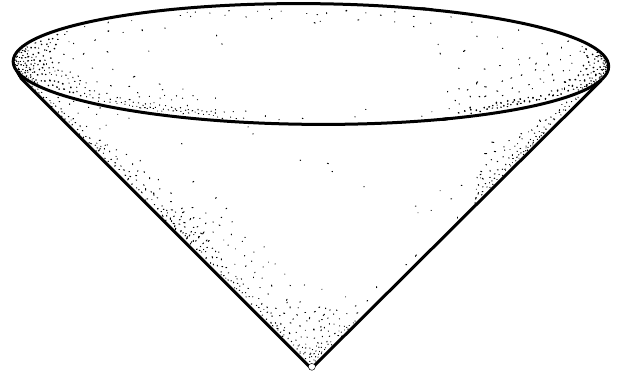
Figure 2 . Future lightcone without